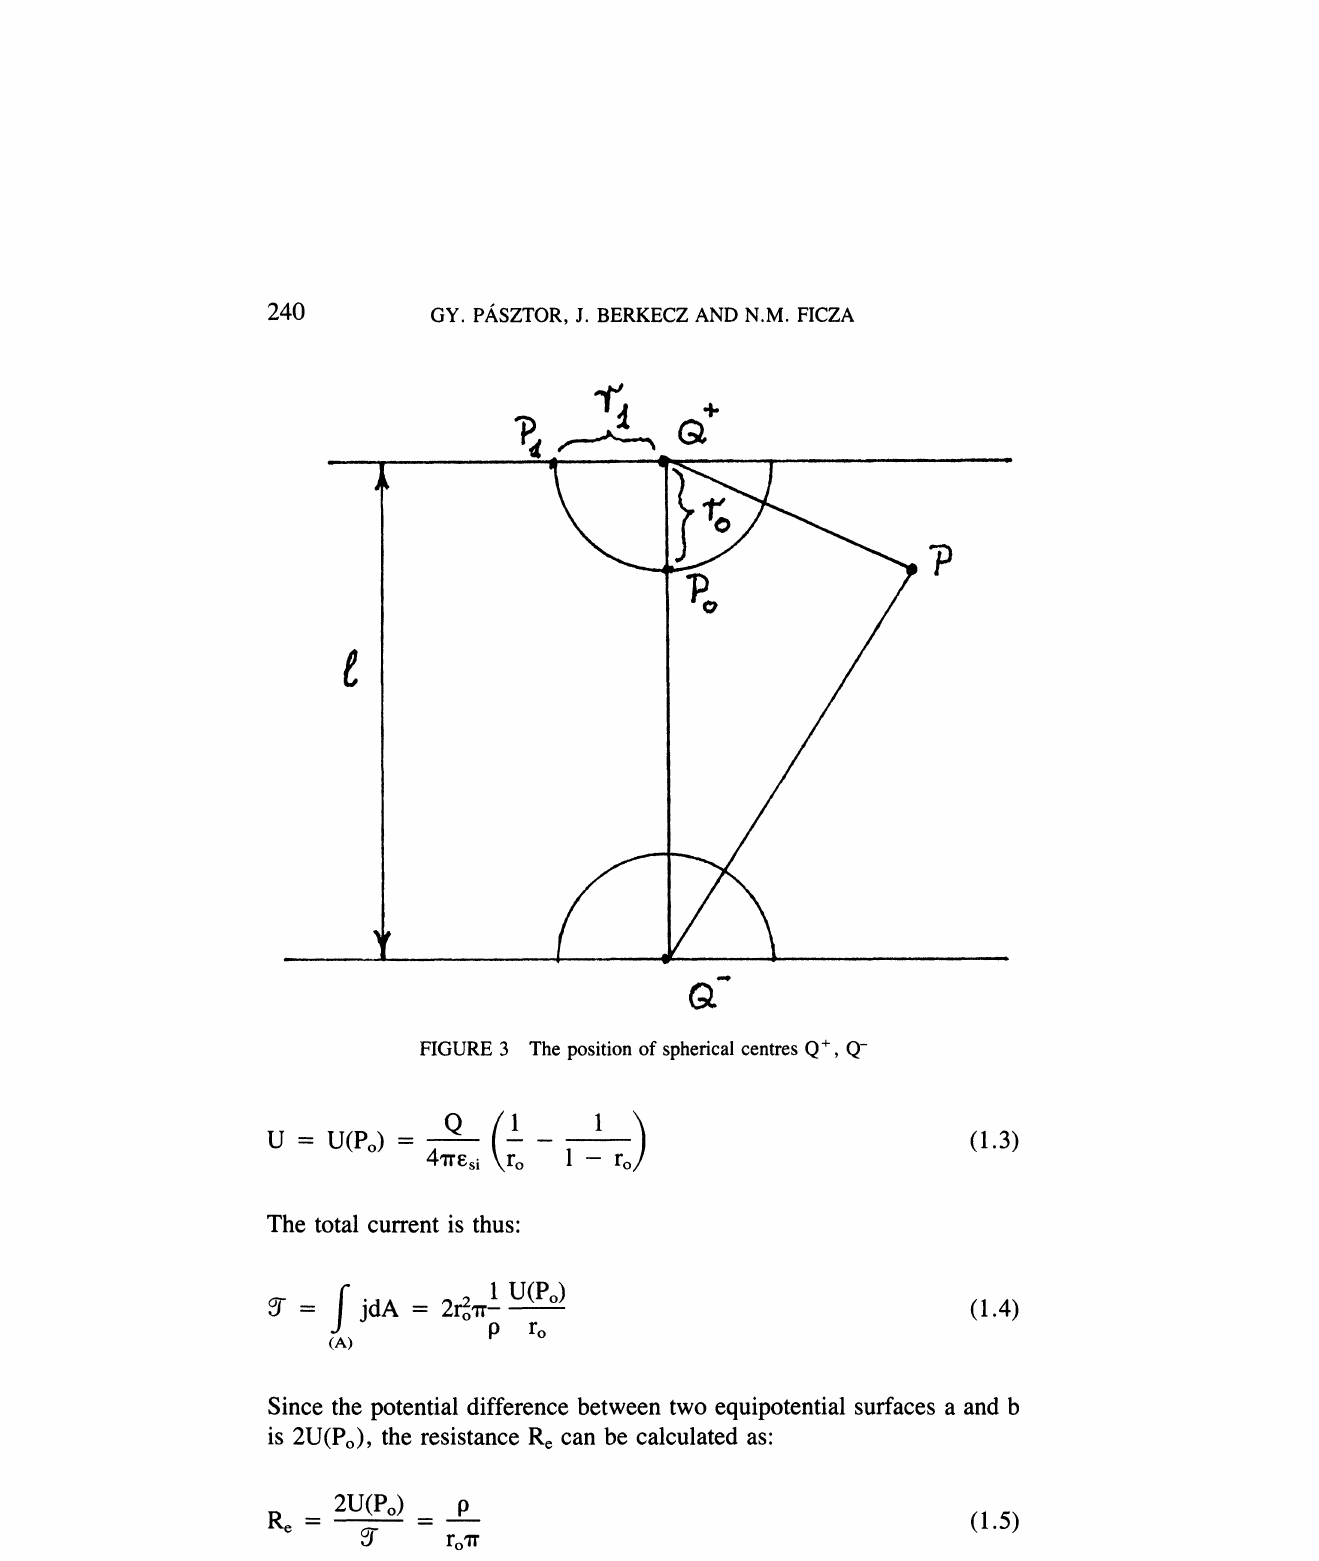
FIGURE 3 The position of spherical centres Q/,